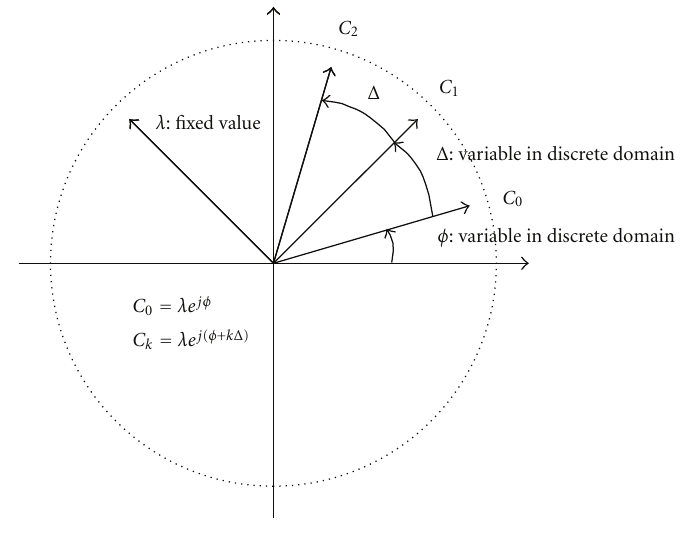
Figure 5: Multiplicative law